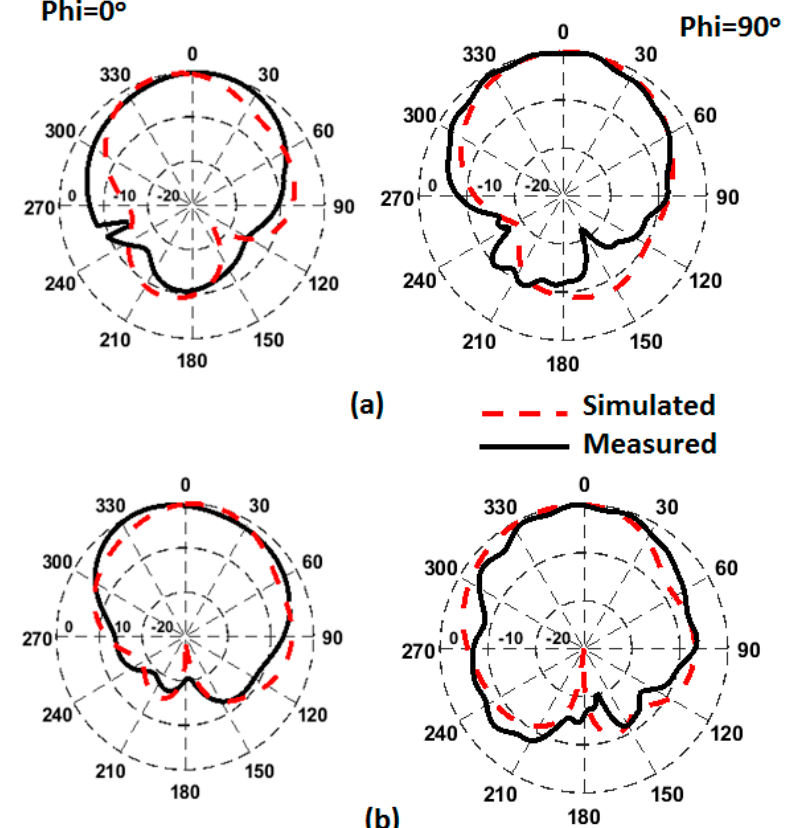
Figure 17. Radiation patterns of four-port DRA ( a ) at 9 ( b ) at 11